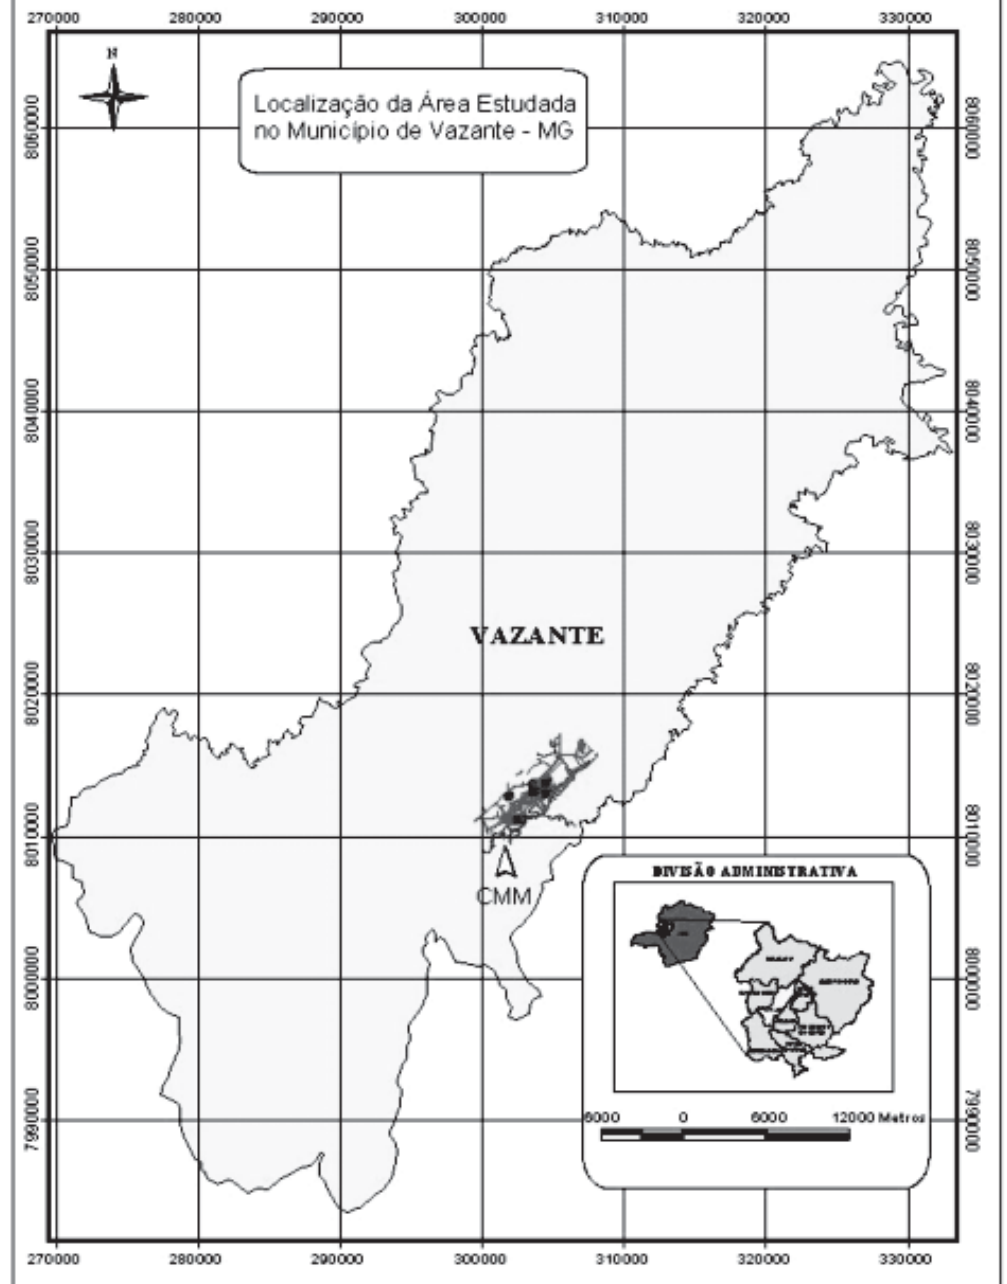
Figura 1. Mapa de localização do município de Vazante, com destaque para a área de mineração de zinco.